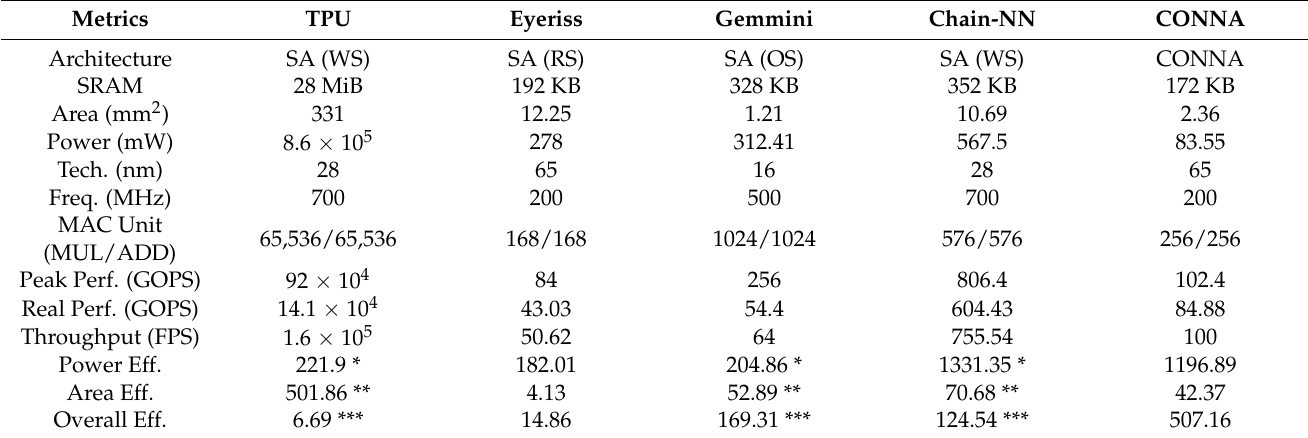
Table 11. Efficiency comparison with the state-of-the-art accelerators